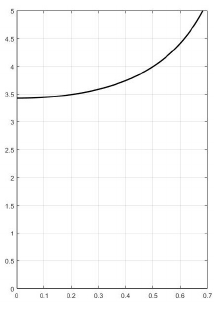
Figure 9. Grapfics of value γ 1 (formula (3.16)) depending on ξ . β 0 = 3 . 1406; h = 0 . 02.